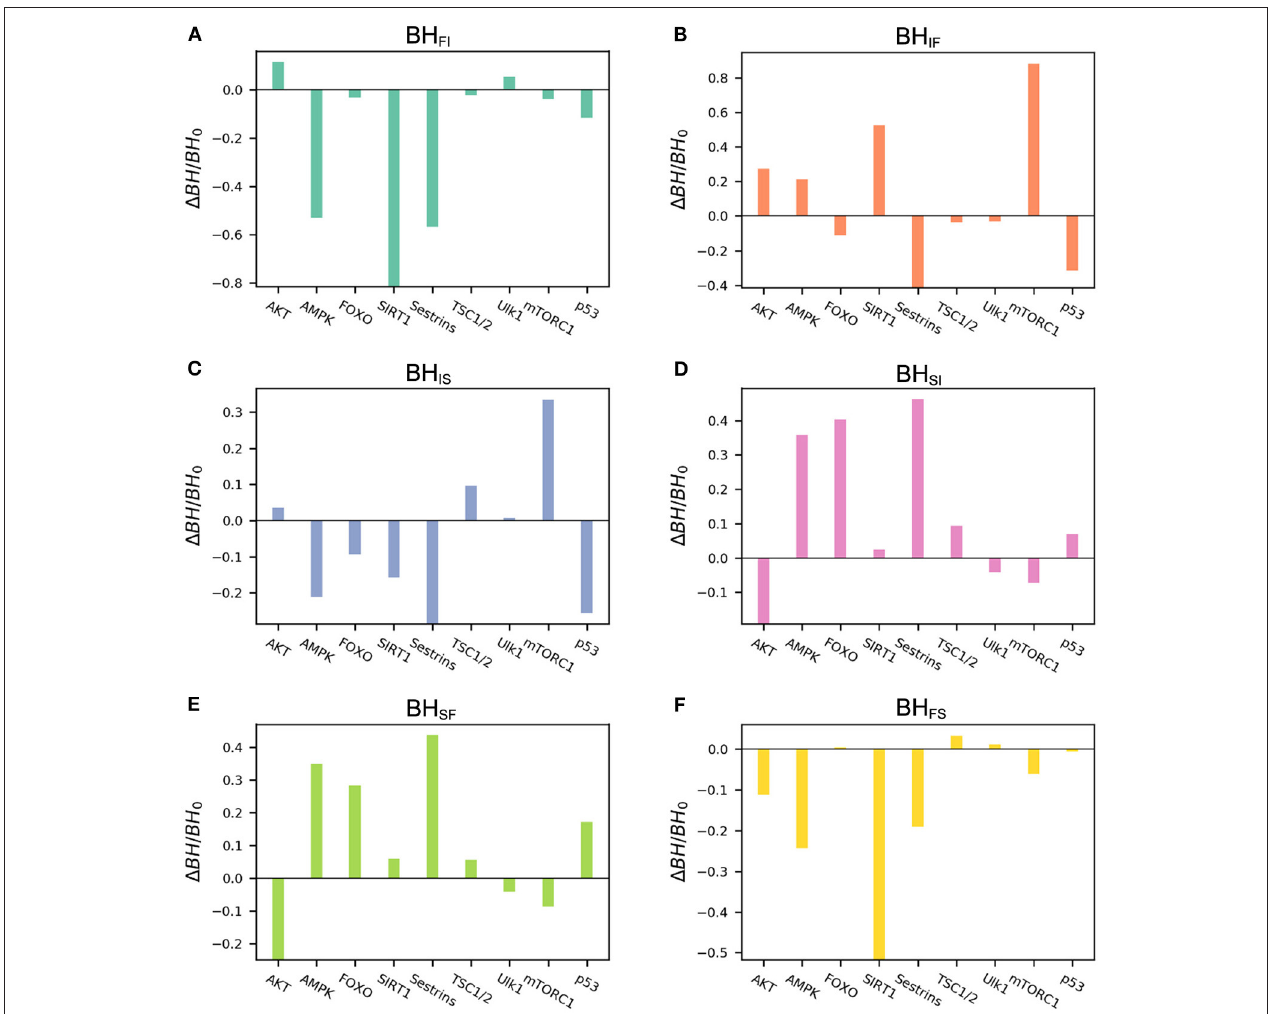
FIGURE 5 | Results of global sensitivity analysis of the barrier height upon changing the basal expression level of different genes. BH 0 , barrier height with the original value; 1 BH , change in barrier height upon changing the basal expression level. (A) Change in barrier height from the fast-aging to the intermediate attractor. (B) Change in barrier height from the intermediate to the fast-aging attractor. (C) Change in barrier height from the intermediate to the slow-aging attractor. (D) Change in barrier height from the slow-aging to the intermediate attractor. (E) Change in barrier height from the slow-aging to the fast-aging attractor. (F) Change in barrier height from the fast-aging to the slow-aging